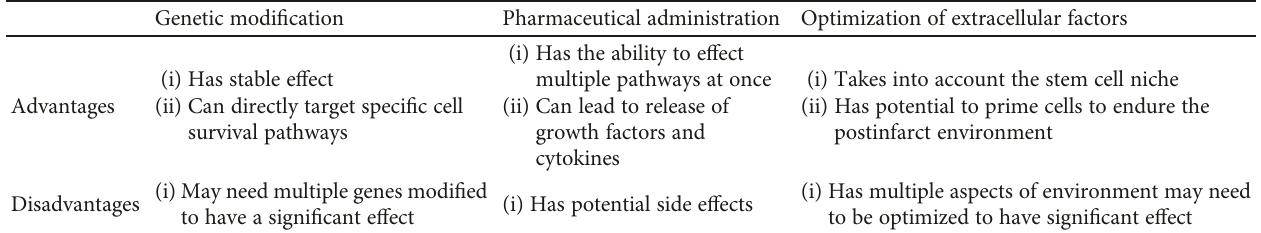
Table 1: Advantages and disadvantages of the various strategies that were discussed. Genetic modi fi